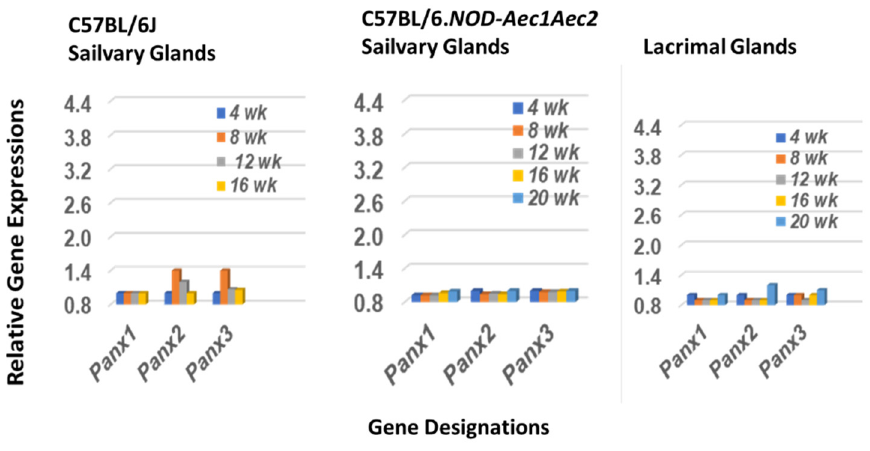
Figure 3. Transcriptome profile of genes encoding the pannexin family proteins. Temporal tran ‐ scriptomic expression profiles of the pannexin genes in the salivary glands of SS NS C57BL/6J mice ( left panel) and SS S C57BL/6.NOD ‐ Aec1Aec2 mice ( middle panel), plus the lacrimal glands of SS S C57BL/6.NOD ‐ Aec1Aec 2 mice ( right panel).